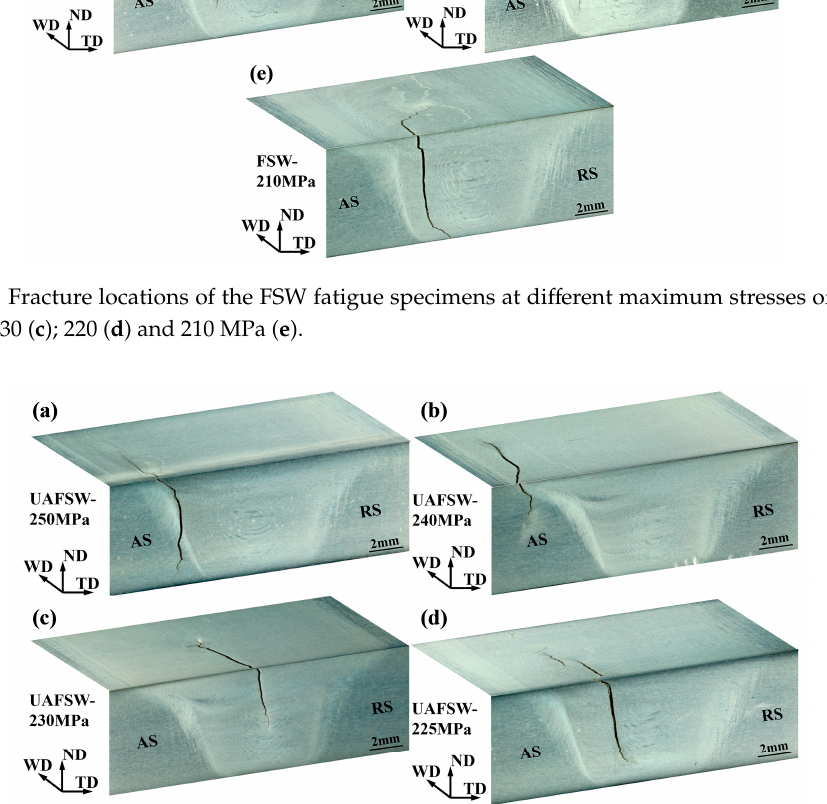
Figure 9. Fracture locations of the UAFSW fatigue specimens at different maximum stresses of 250 ( a ); 240 ( b ); 230 ( c ) and 225 MPa ( d